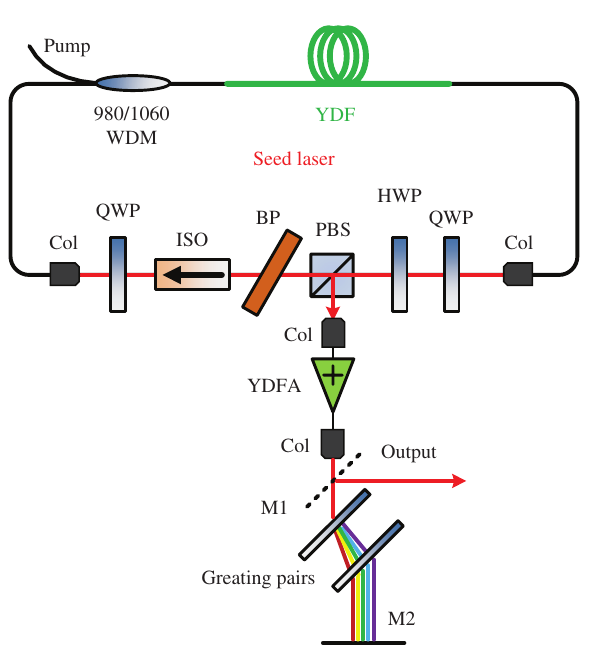
Figure 4: Home-made 1- μ m mode-locked fiber laser for the measurement of nonlinear saturable absorption property of the Ag nanoplates SA. Col, collimator; WDM, wavelength division multiplexer; YDF, Yb-doped fiber; HWP, half wave plate; QWP, quarter wave plate; PBS, polarization beam splitter; BP, birefringent plate; YDFA, Yb-doped fiber amplifier; ISO, isolator; M,